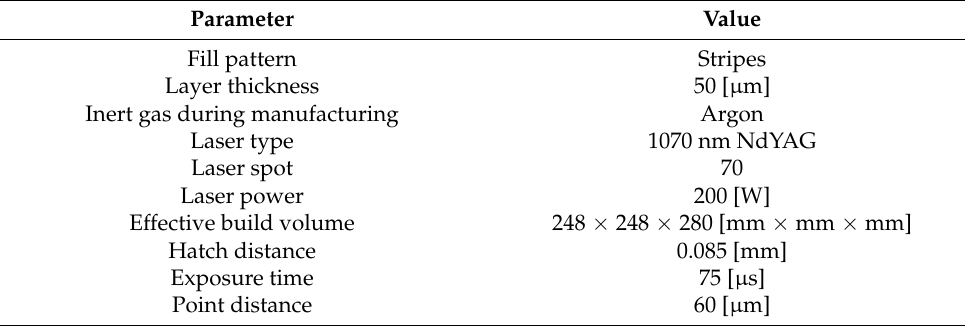
Table 1. SLM machine parameters.